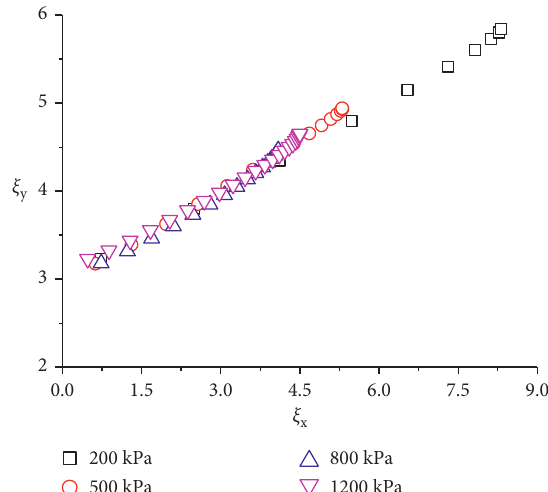
Figure 4: CT tests of Shuangjiangkou rockfill materials [11].